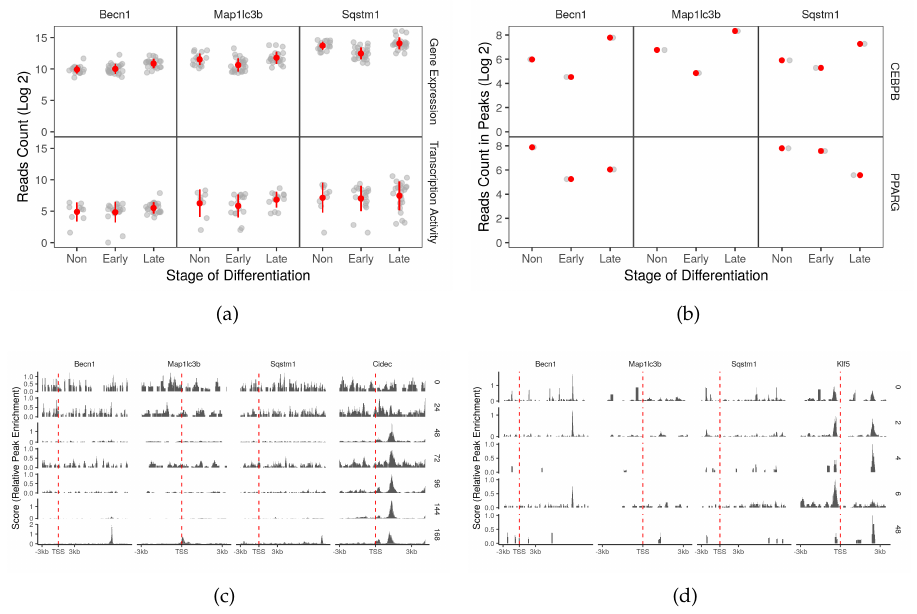
Figure 4. Key autophagy gene targets of the adipogenic transcription factors. ( a ) The reads count of three key autophagy genes in RNA-Seq samples (n = 66) were used to represent the gene expression. The reads count in peaks of POLR2A in genomic region of key autophagy genes from ChIP-Seq samples (n = 12) was used to represent the transcription activity. ( b ) The reads count in peaks of CEBPB and PPARG ChIP-Seq samples (n = 9 and 13) was used to represent peak enrichment. The Peaks from the ( c ) PPARG and ( d ) CEBPB ChIP-Seq samples were visualized by the time point and position around the transcription start site ( ± 3 kb). Cidec and klf5 were used as positive control